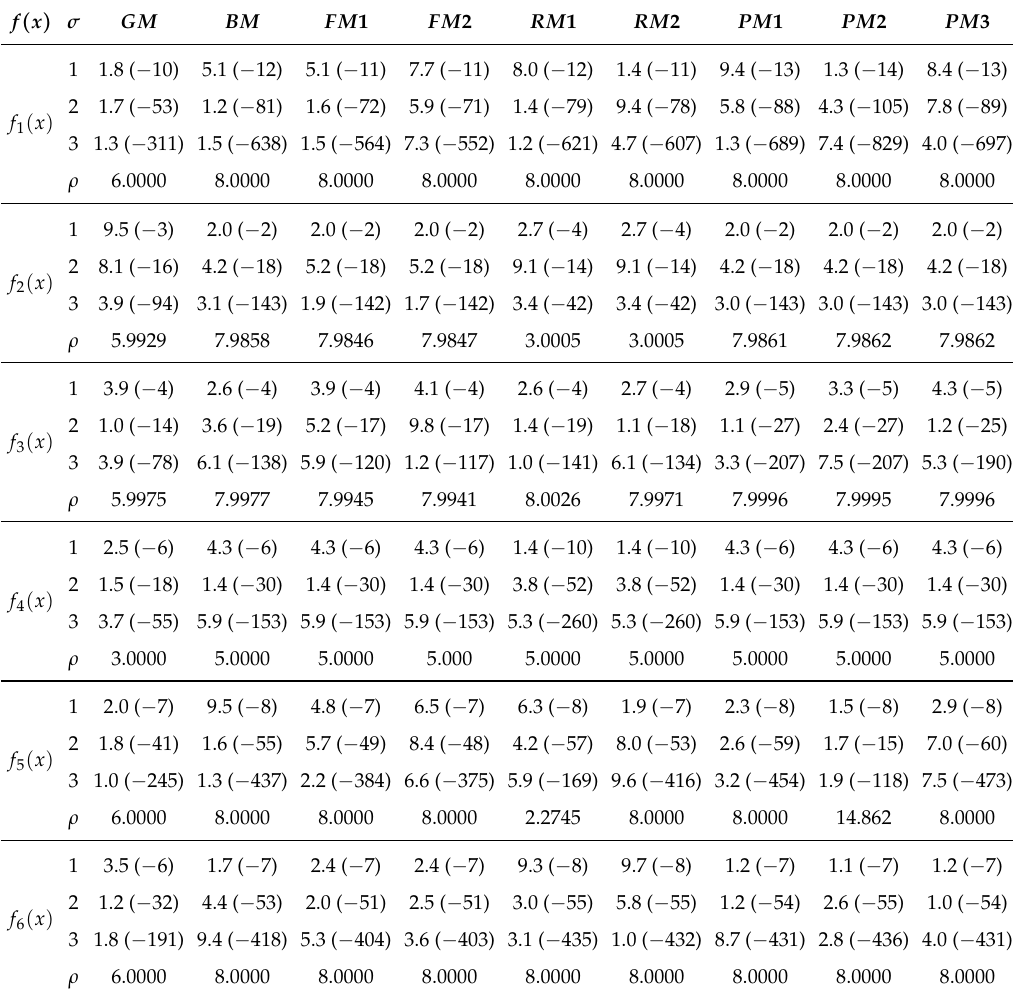
Table 2. Errors between iterations ( | x σ + 1 − x σ | ) among different iteration functions.